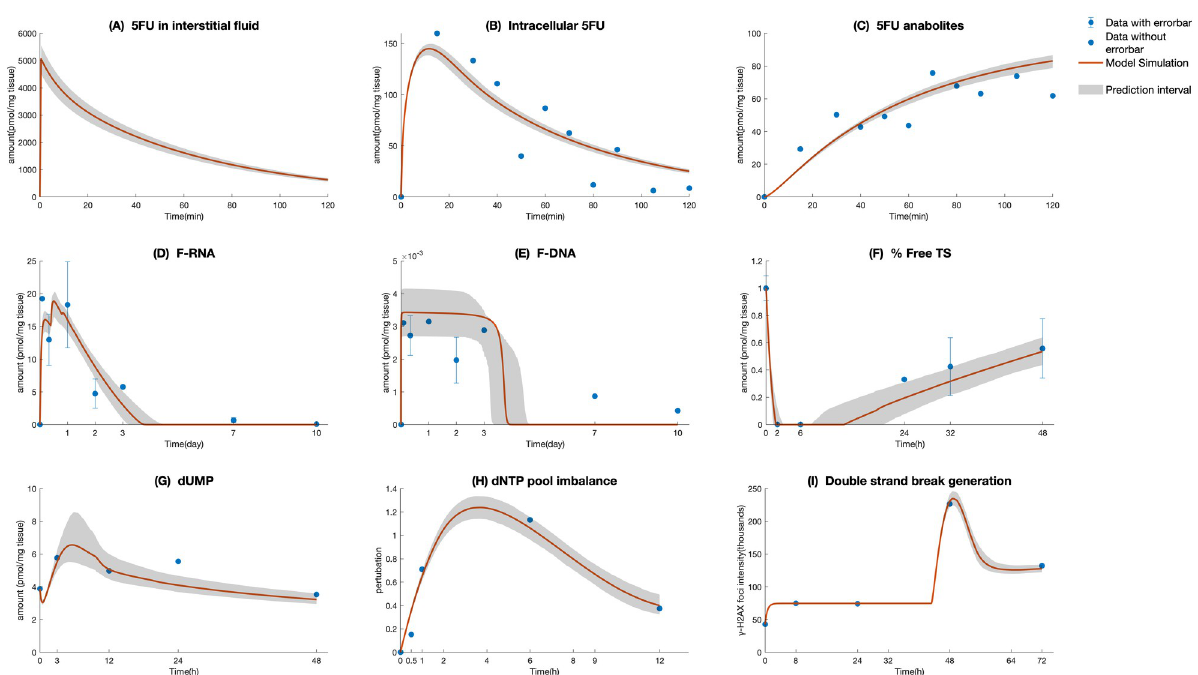
Fig 3. Time profiles of intermediate components in cellular model. (A) 5-FU in interstitial fluid, (B) intra-cellular 5-FU, (C) 5-FU anabolites, (D) F-RNA, (E) F-DNA, (F) % Free TS, (G) dUMP, (H) dNTP pool imbalance, (I) double-strand break generation. Red curve, model simulation; solid blue circle, literature data points; and error bar represents standard errors. The shaded areas represent the 0.7 credible regions.